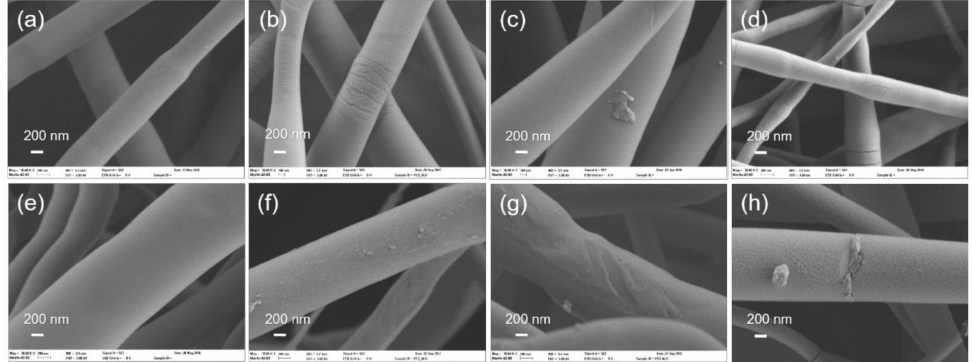
Figure 4. SEM micrographs of PES fibres ( a ) before ALD, or ( b ) with 2 nm Al 2 O 3 (TMA + H 2 O), ( c ) with 30 nm Al 2 O 3 (TMA + H 2 O), ( d ) with 2 nm Al 2 O 3 (TMA + O 3 ), ( e ) with 30 nm Al 2 O 3 (TMA + O 3 ), ( f ) with 2 nm ZnO, ( g ) with 30 nm ZnO, and ( h ) with 1 nm Al 2 O 3 + 30 nm